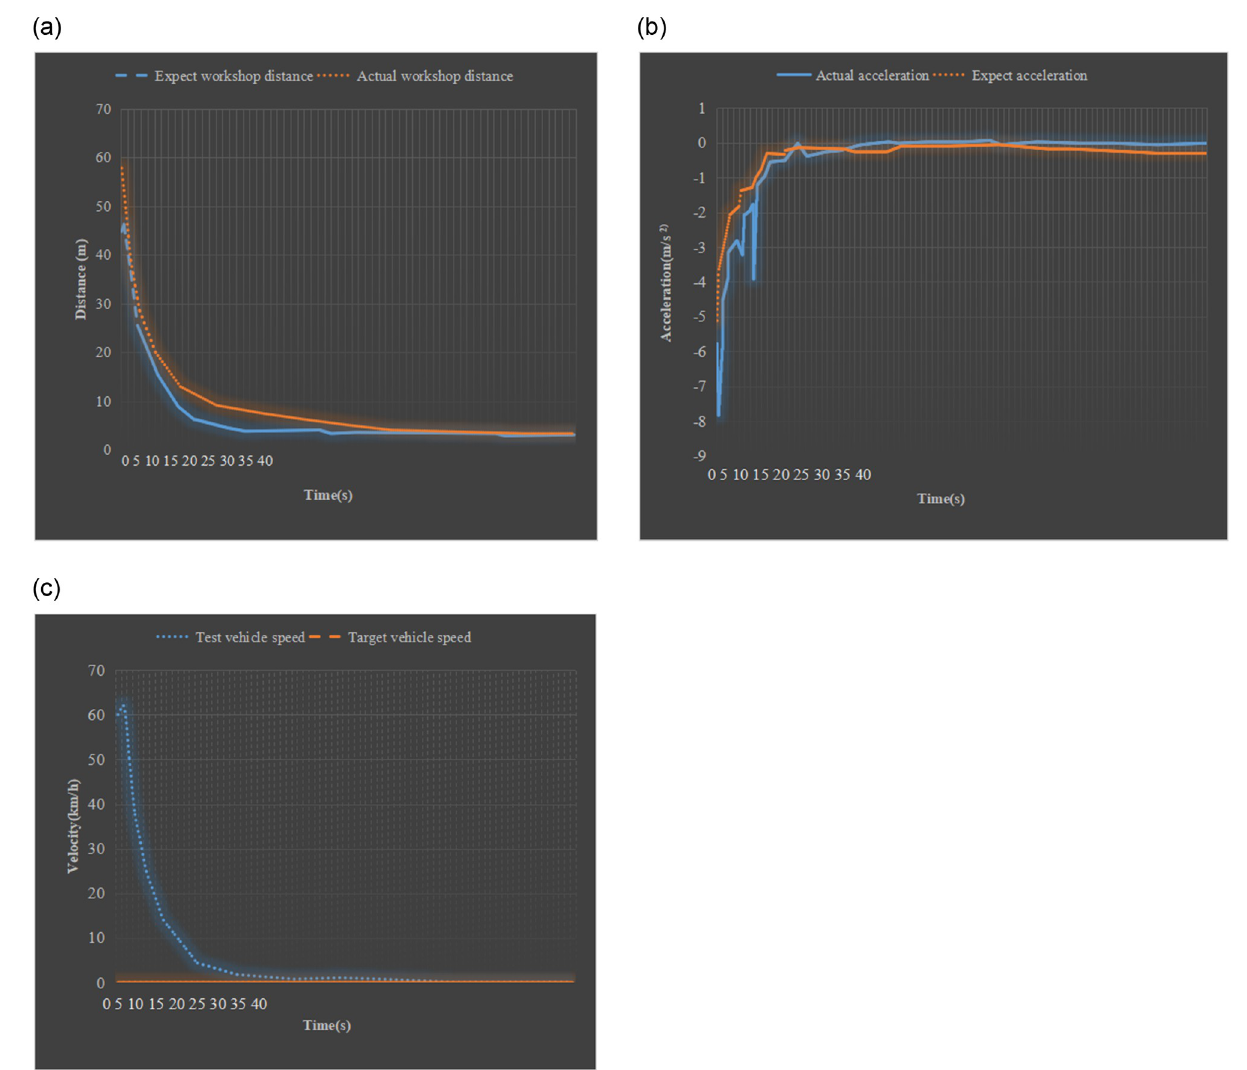
Fig 13. Simulation results of anti-collision of front vehicle at rest (a) comparison between actual distance and expected distance (b) comparison between actual acceleration and expected acceleration (c) comparison of two vehicle speeds.